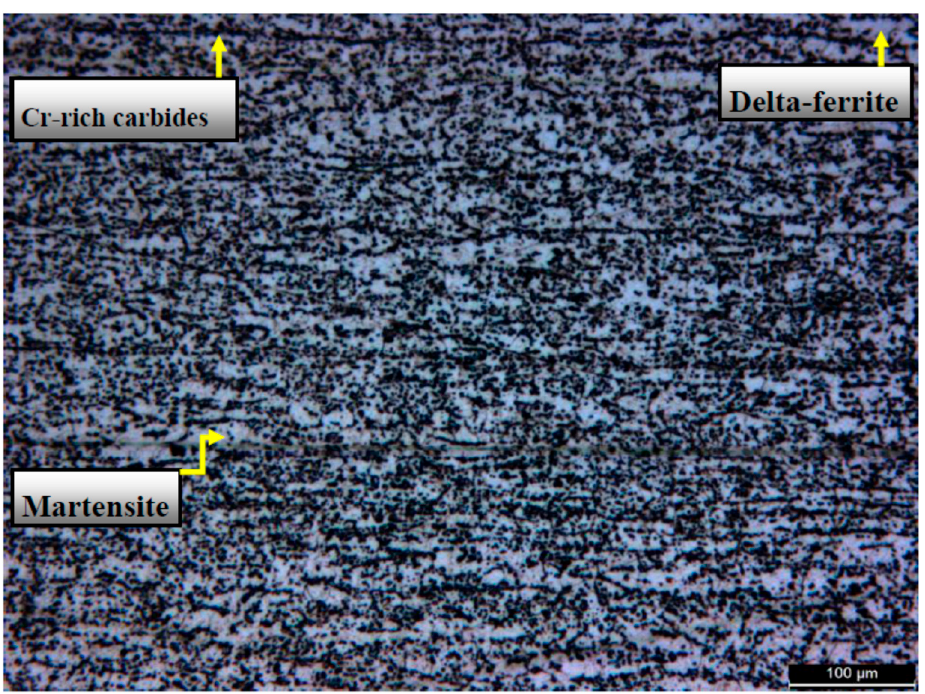
Figure 7. 420 base metal microstructure.